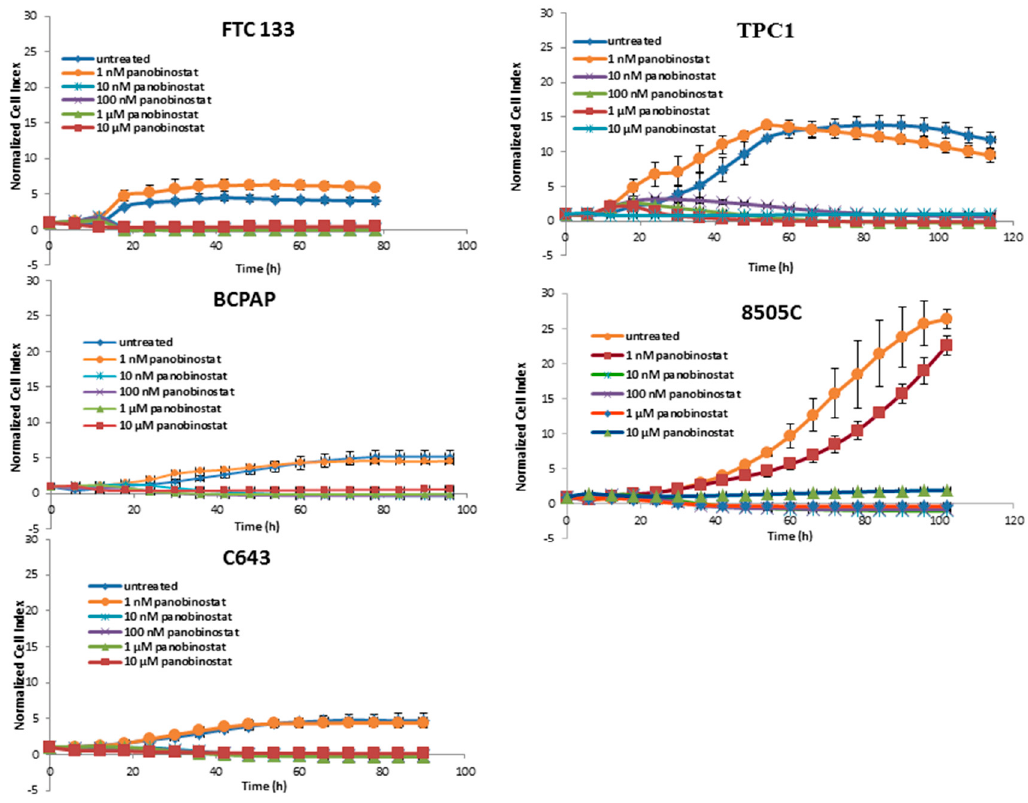
Figure 1. Real time cell viability of thyroid cancer cells treated with panobinostat. FTC133, TPC1, BCPAP, 8505C, and C643 cells were plated on gold-coated 96-well plates. After approx. 24 h, panobinostat was added at concentration between 1 nM and 10 µM. The cell viability was monitored constantly for up to 100 h. Cell index was normalized to the time point of treatment. Shown are means ± SD of three independent experiments performed in triplicates.